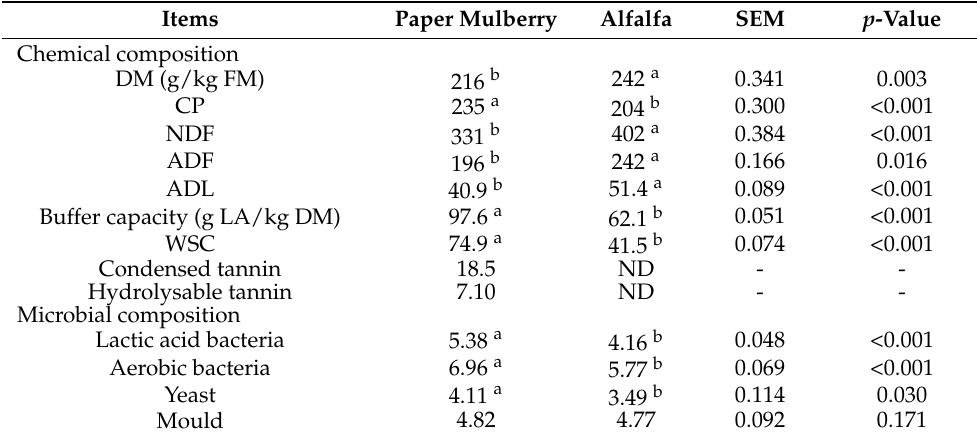
Table 1. Chemical composition (g/kg DM) and microbial counts (log 10 cfu/g FM) of paper mulberry and alfalfa materials.